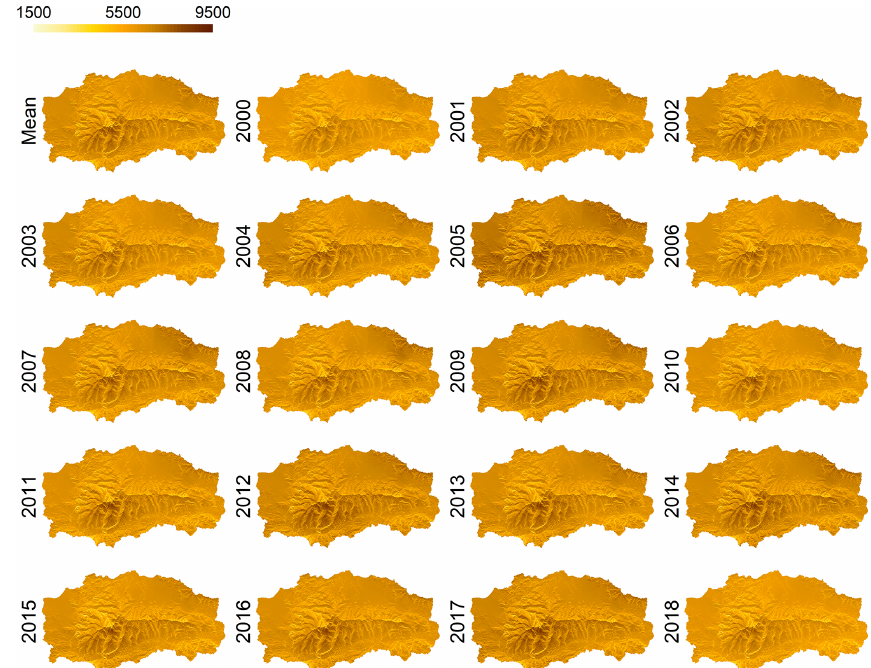
Figure 12. Annual global radiation (MJm − 2 yr − 1 ) in the study period (2001–2018) in SN.